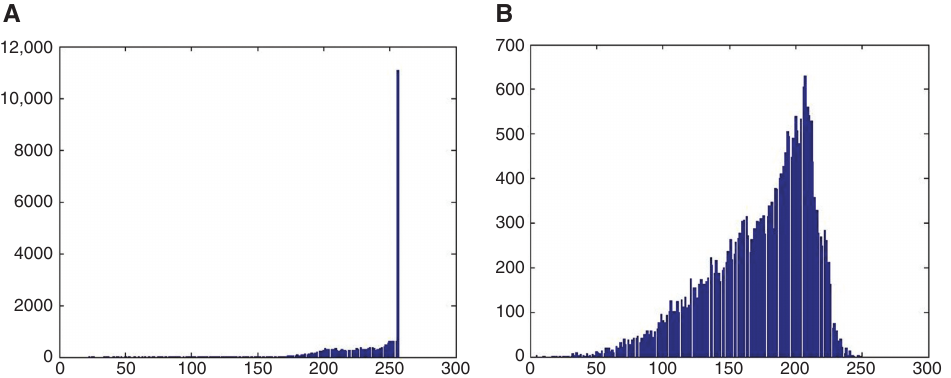
Figure 3: Samples of the Histogram Diagram for Healthy Grains and Grains Infected with Fusarium used for Obtaining Central Moments. (A) Desired histogram diagram for healthy grains. (B) Histogram diagram for grains infected with Fusarium